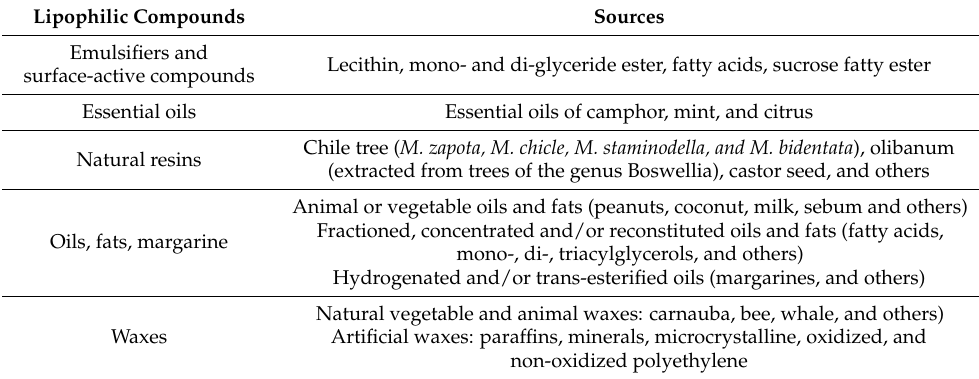
Table 2. Lipophilic compounds used in